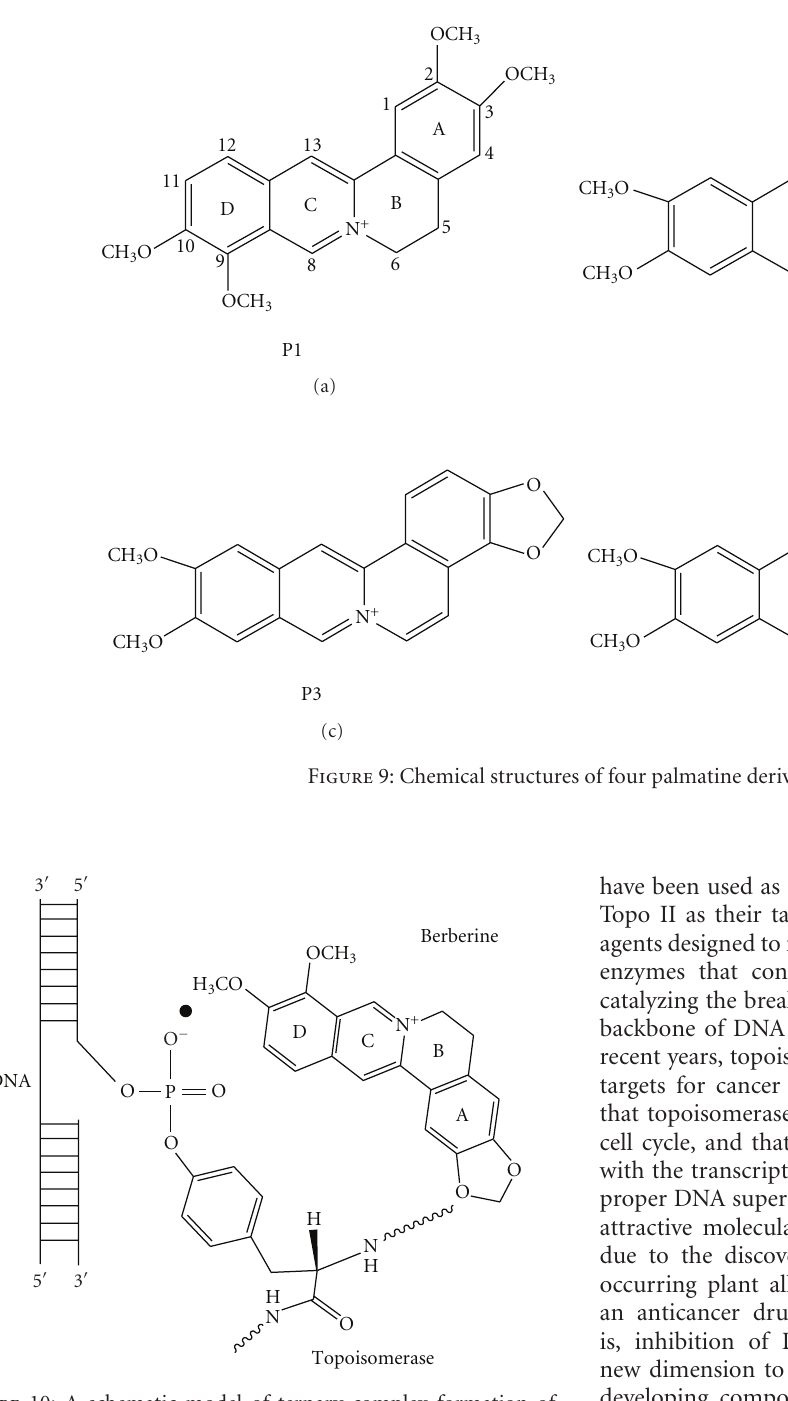
Figure 10: A schematic model of ternary complex formation of berberine on binding to Topo I and